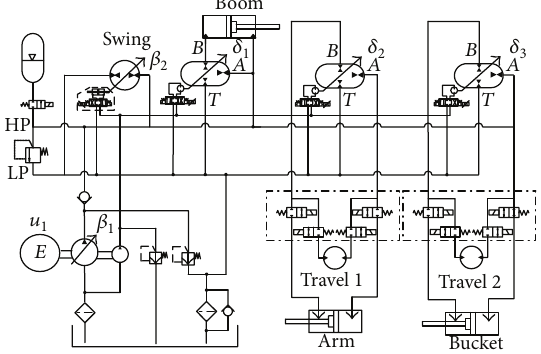
Figure 2: Hydraulic hybrid excavator based on CPR combined switched function.